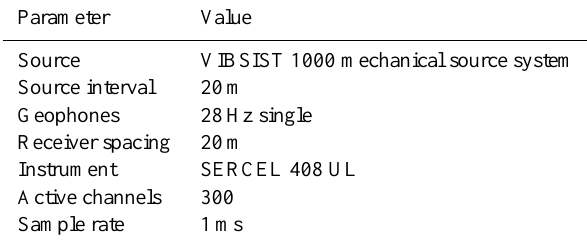
Table 1. Acquisition parameters.